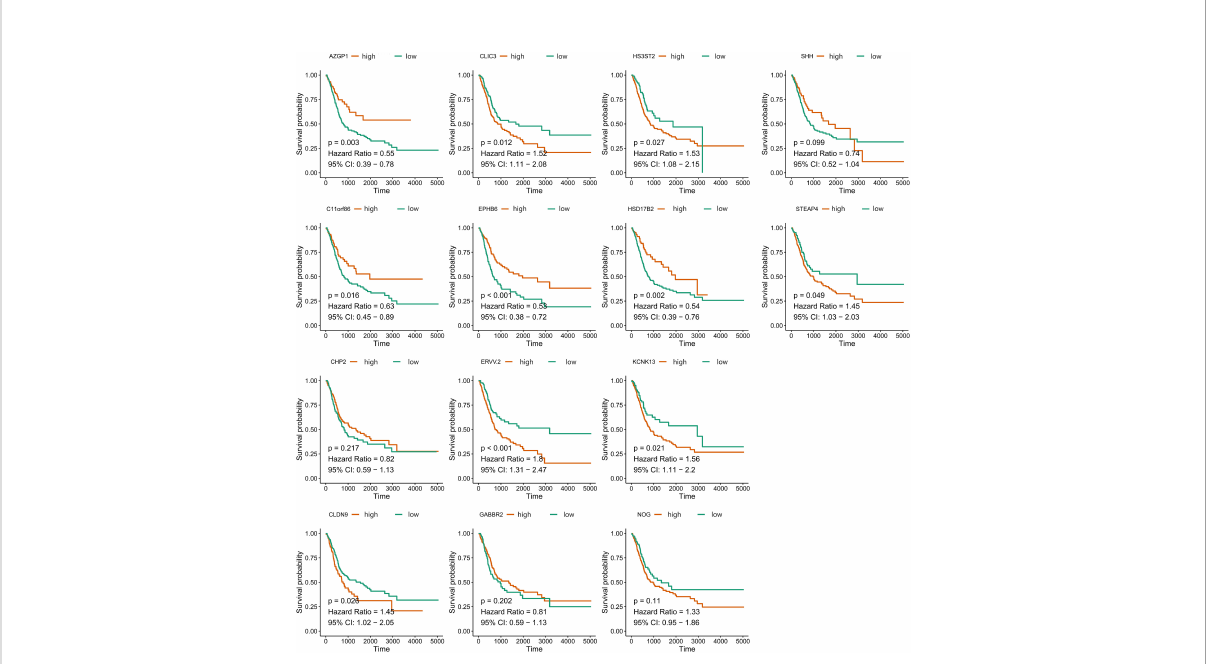
FIGURE 7 Overall survival of 14 stably-expressed genes. Kaplan-Meier survival curves showed the different correlation between OS and expression level of candidate